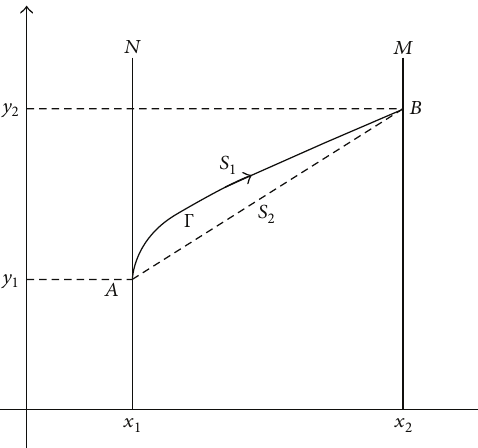
𝑛 is the order-1 periodic solution of system